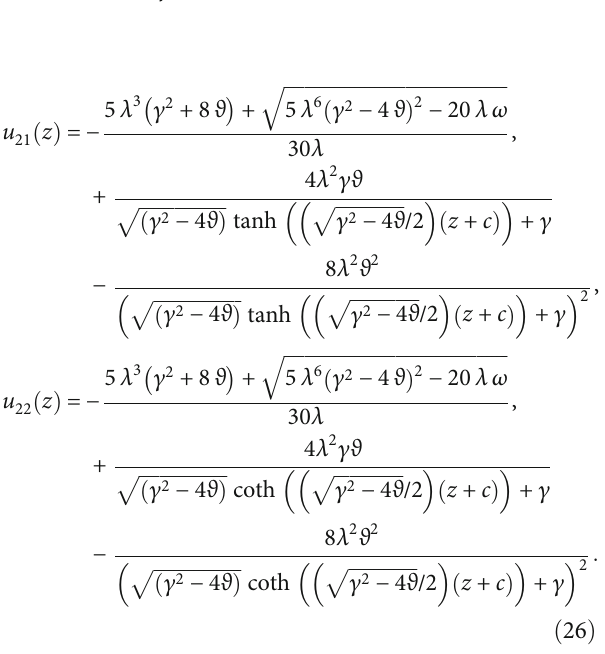
ffiffiffiffiffiffiffiffiffiffiffiffiffiffiffiffiffiffi 4 ϑ − γ 2 ð